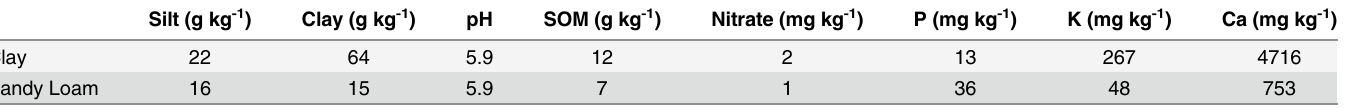
Table 1. Main soil properties of the soil samples from Beaumont Center and Eagle Lake Station,